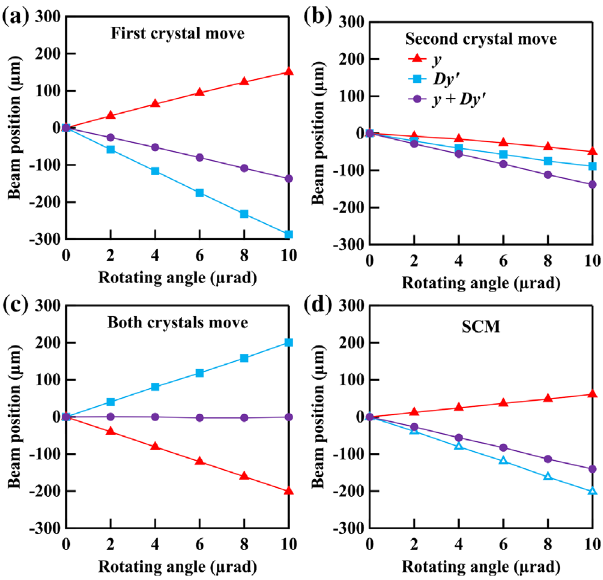
FIG. 4. Simulated beam position response as a function of the rotation angle of (a) the first crystal, (b) the second crystal, (c) both crystals of the DCM, and (d) the SCM crystal. The markers represent the extracted source position y (triangles), projected source angle Dy 0 (squares), and the total beam position y þ Dy 0 . The curves provide a visual aid.